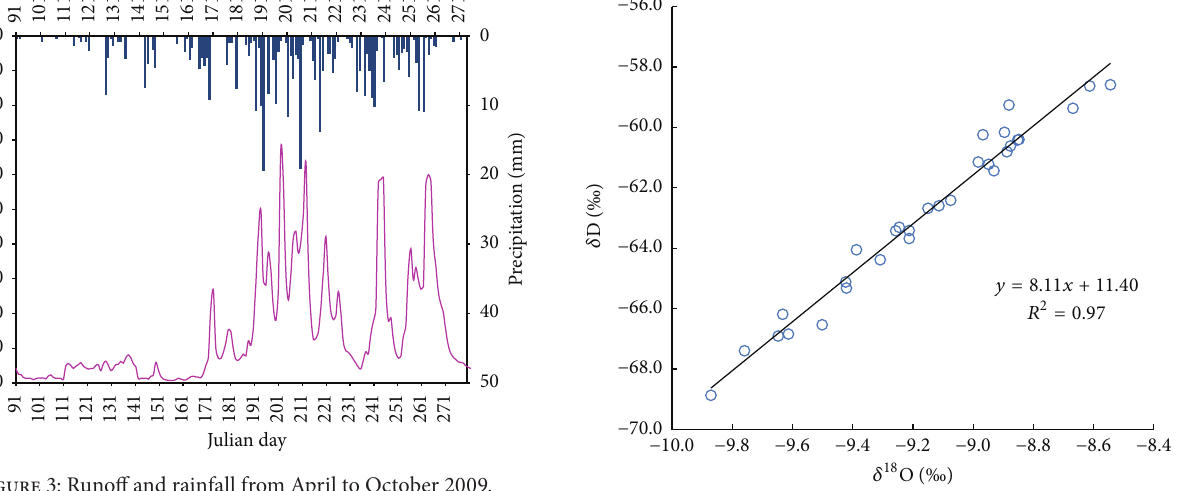
Figure 3: Runoff and rainfall from April to October 2009.